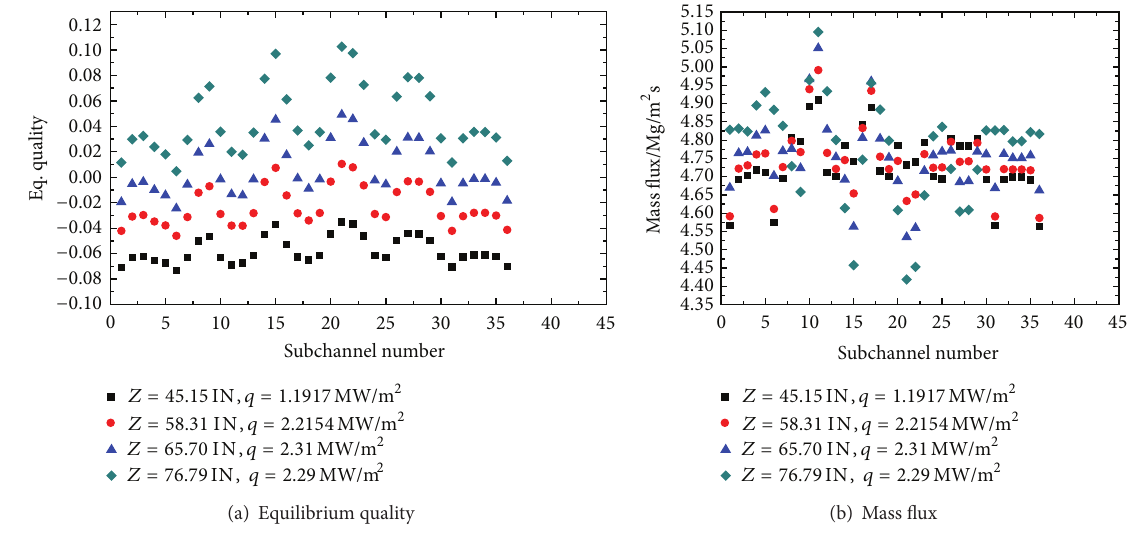
Figure 8: Subchannel equilibrium quality and mass flux at different grid